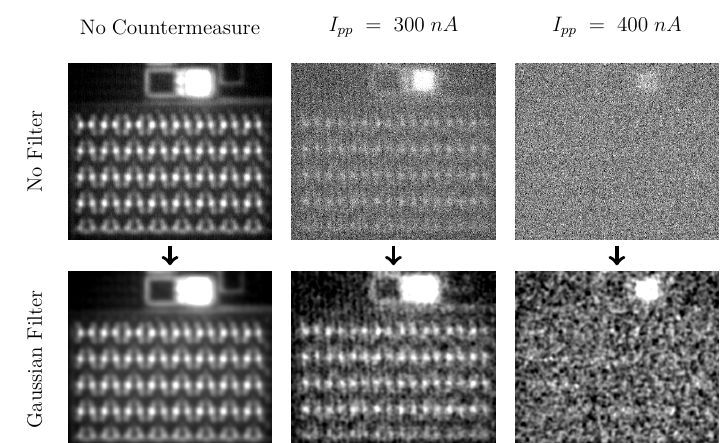
Figure 18: Effect of our proof-of-concept countermeasure on TLS results with and without 2D Gaussian filtering and enhanced contrast applied. Left column: countermeasure disabled, 40% laser power, 72 s scan time. Middle column: countermeasure set at I 100% laser power, 5x120 s scan time. Right column: countermeasure set at I 100% laser power, 5x120 s scan